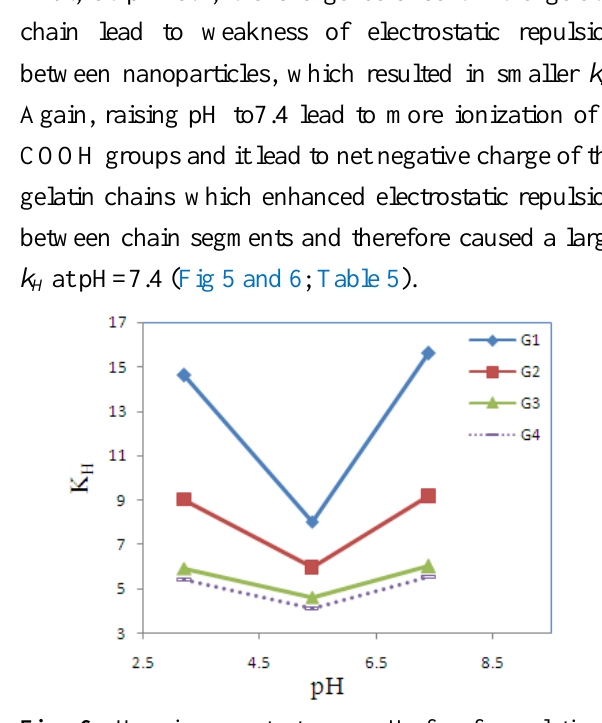
Fig. 6. Huggins constants vs. pH for for gelatin